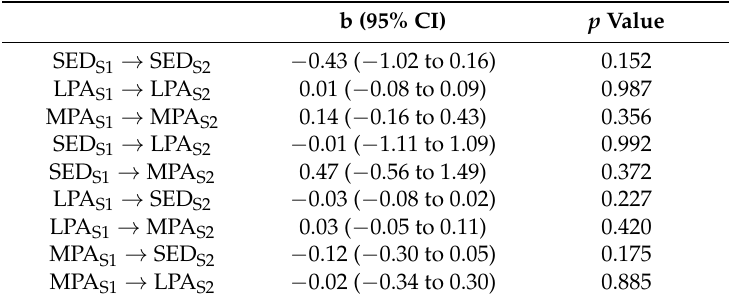
Table 3. Associations between time (min) spent in different physical activity intensities or sedentary time between pairs of 2-h periods within a shift. b (95% CI) p Value SED P1 → SED P2 − 0.23 ( − 0.52 to 0.06) 0.116 LPA P1 → LPA P2 0.003 ( − 0.06 to 0.06) 0.993 MPA P1 → MPA P2 0.06 ( − 0.18 to 0.30) 0.606 SED P1 → LPA P2 0.36 ( − 0.17 to 0.89) 0.183 SED P1 → MPA P2 − 0.14 ( − 0.70 to 0.41) 0.618 LPA P1 → SED P2 0.01 ( − 0.08 to 0.04) 0.710 LPA P1 → MPA P2 − 0.01 ( − 0.7 to 0.05) 0.793 MPA P1 → SED P2 − 0.04 ( − 0.18 to 0.09) 0.525 MPA P1 → LPA P2 − 0.02 ( − 0.25 to 0.22)